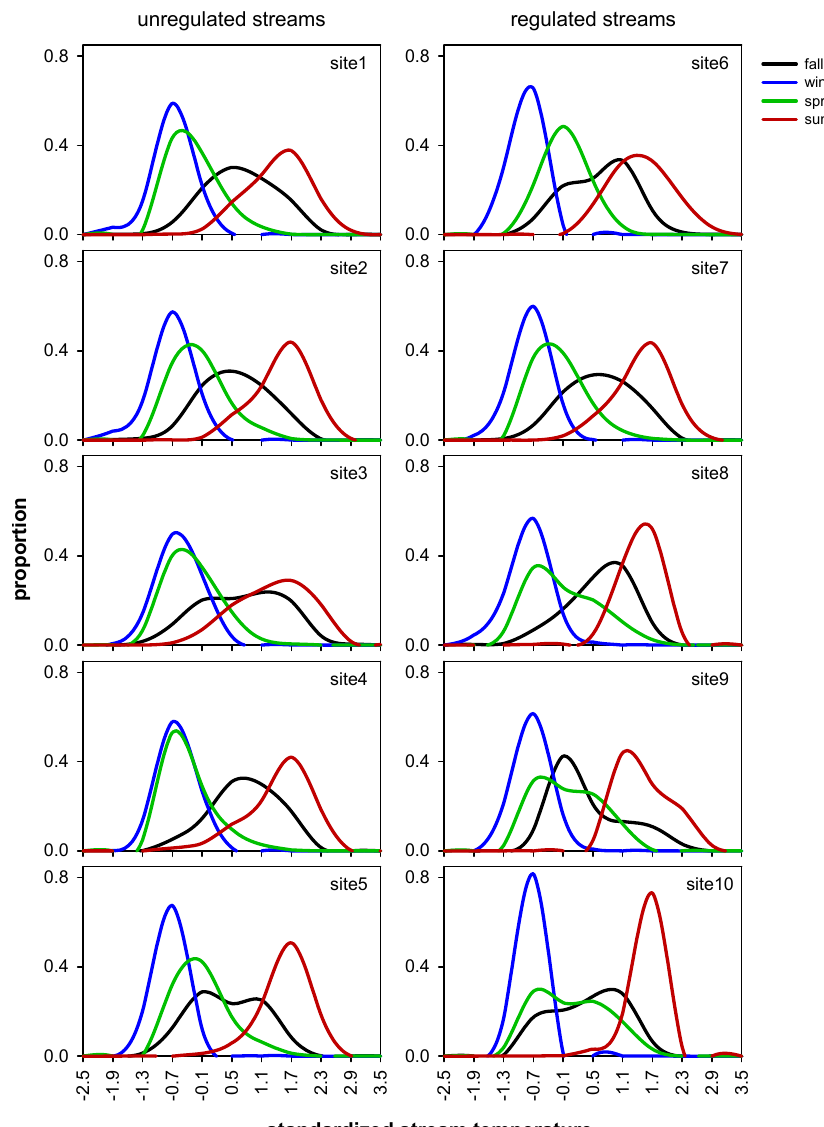
Figure 2. Density plots of standardized temperatures (1979–2009) by season (winter – blue line; spring – green line; summer – red line; fall – black line) in unregulated (left panel) and regulated (right panel) streams using time series of daily